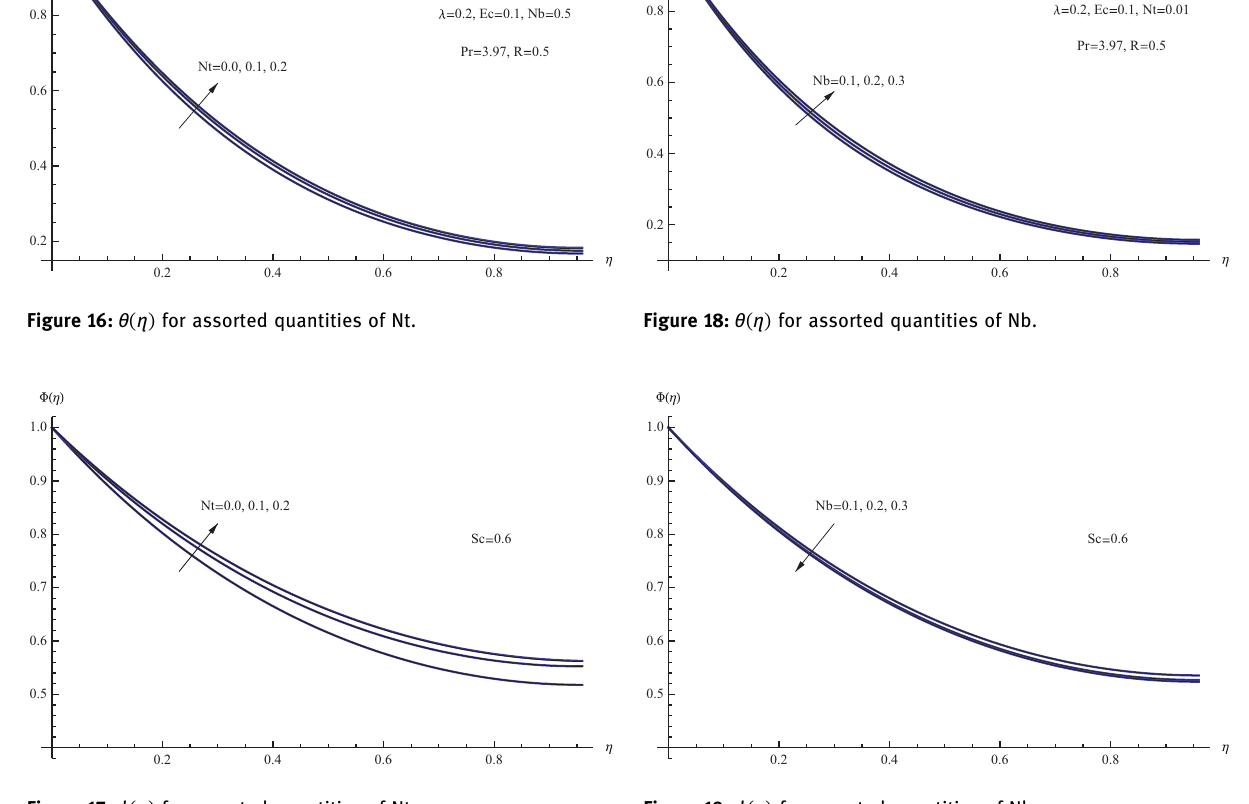
Figure 19: ( ) ϕ η for assorted quantities of